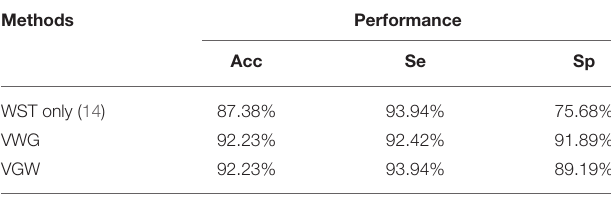
TABLE 4 | Classification performance based on different noise reduction methods:accuracy (Acc), sensitivity (Se), and specificity (Sp).